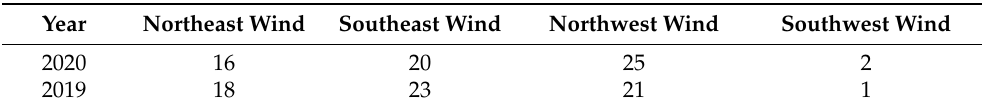
Table 2. The number of days with different wind directions during the sampling period in 2020 and the same period in 2019. The total number of experimental days was 63